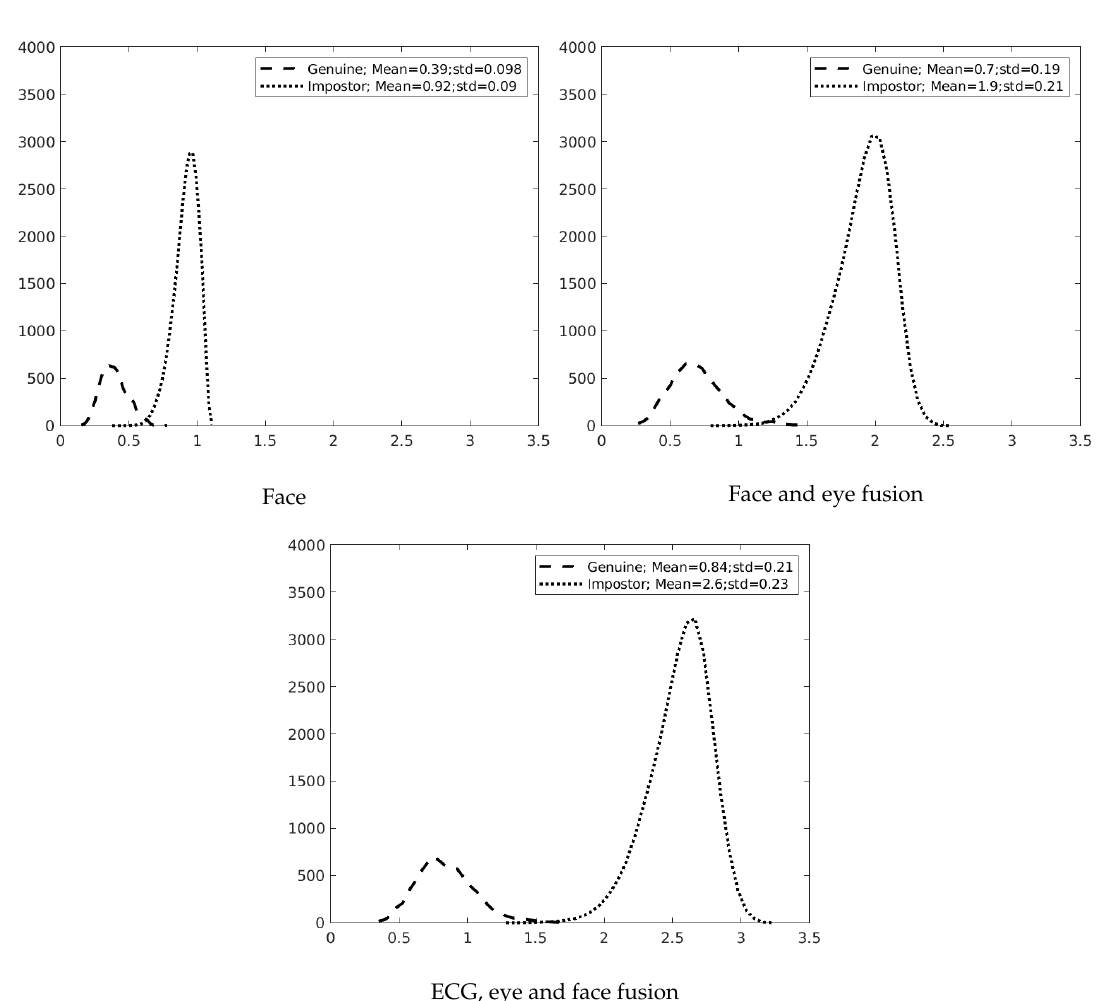
Figure 9. Distribution impostor/genuine curves from the inter-session scenario. The fusion is at the score level using the sum